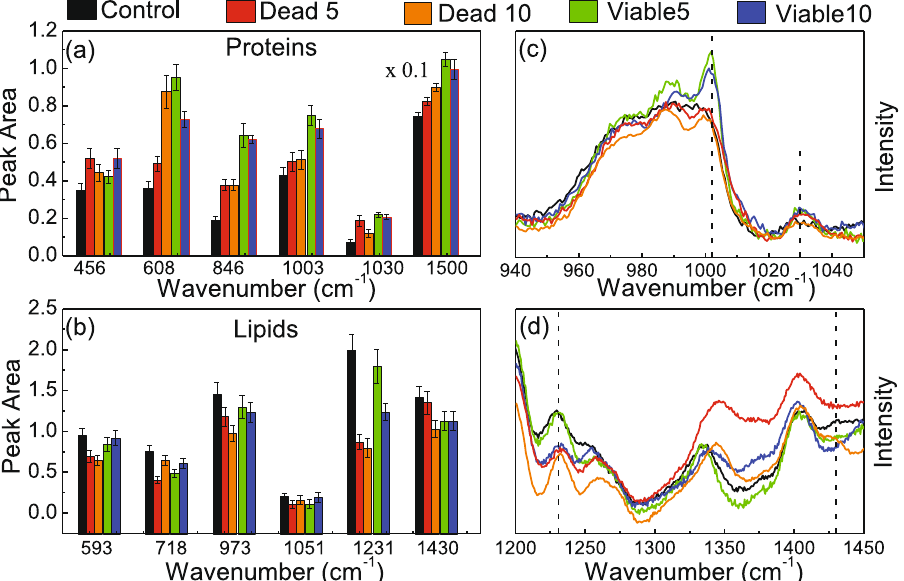
Figure 3. Comparison between the values of average intensities and standard deviations of SERS peaks related to proteins ( a ) and lipids ( b ). Spectral details are shown in ( c and d ) for proteins and lipids,